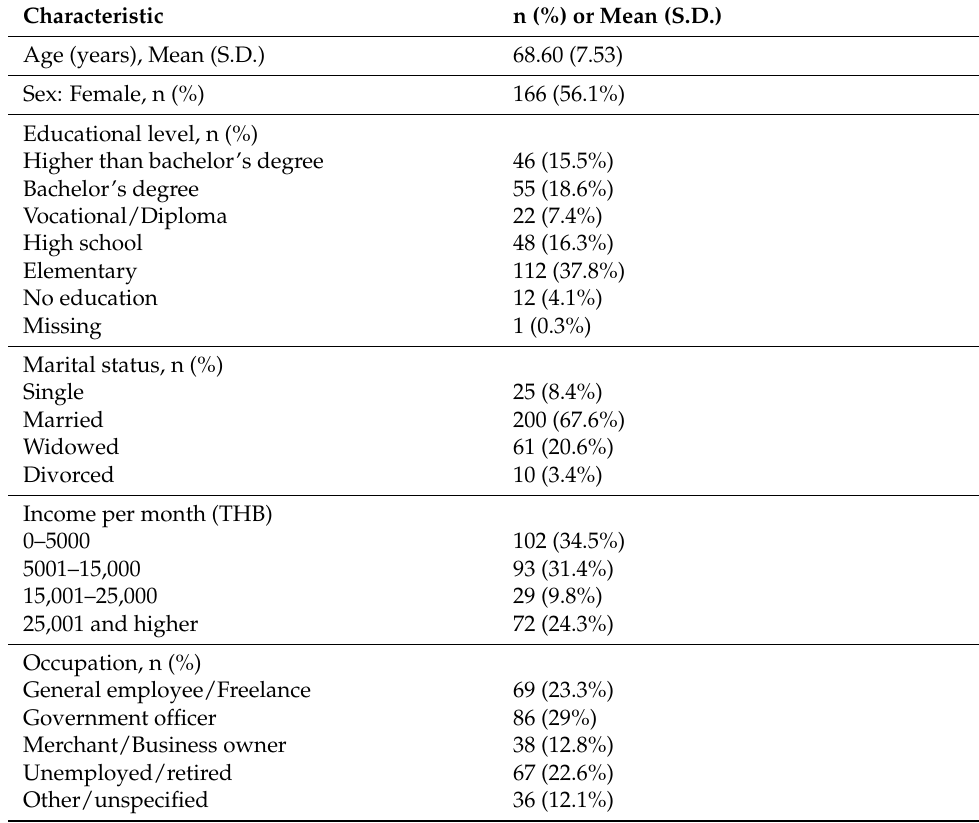
Table 1. Sociodemographic